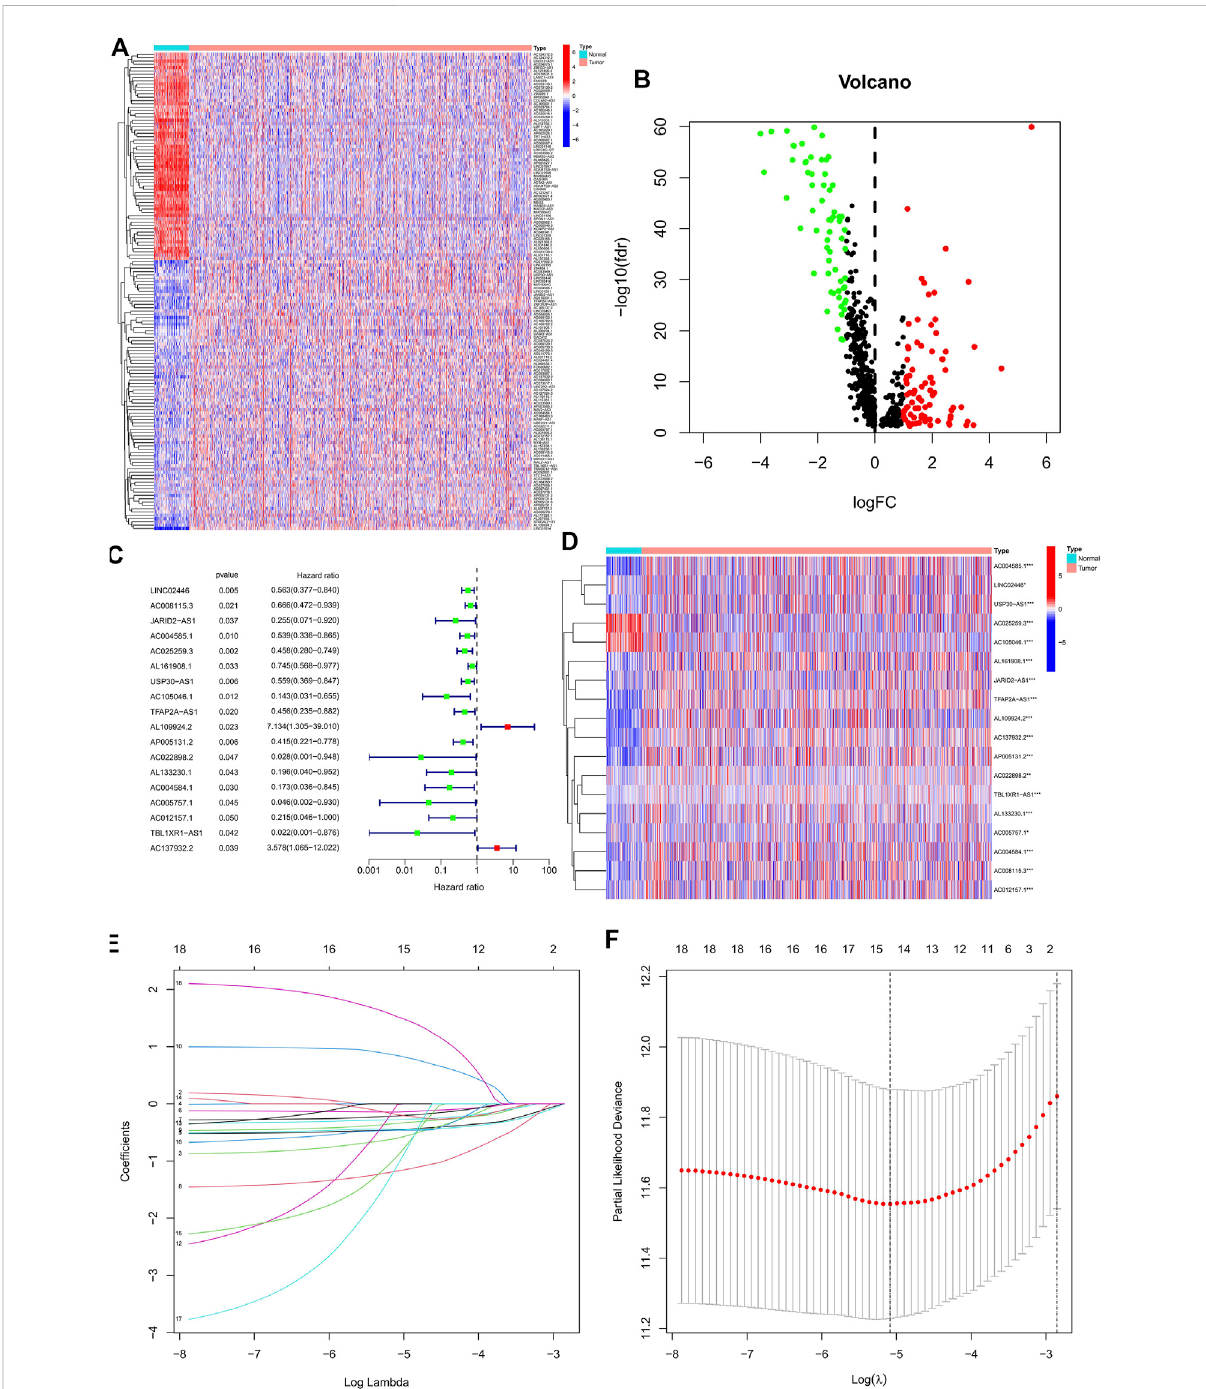
FIGURE 1 Identi fi cation of the prognostic ERS-related lncRNAs for BC patients. (A) Heatmap of 145 differentially expressed lncRNAs. (B) Volcano plot of ERS-related lncRNAs. Red dots indicate upregulated lncRNAs in tumor tissues while the green dots indicate downregulated lncRNAs. (C,D) Forest plot (C) and heatmap (D) of the prognostic ERS-related lncRNAs extracted by the univariate Cox regression analysis. (E,F) LASSO variable trajectory plot for 1,000 cross validations (E) and LASSO coef fi cient pro fi le (F) . ERS, endoplasmic reticulum stress; BC, breast